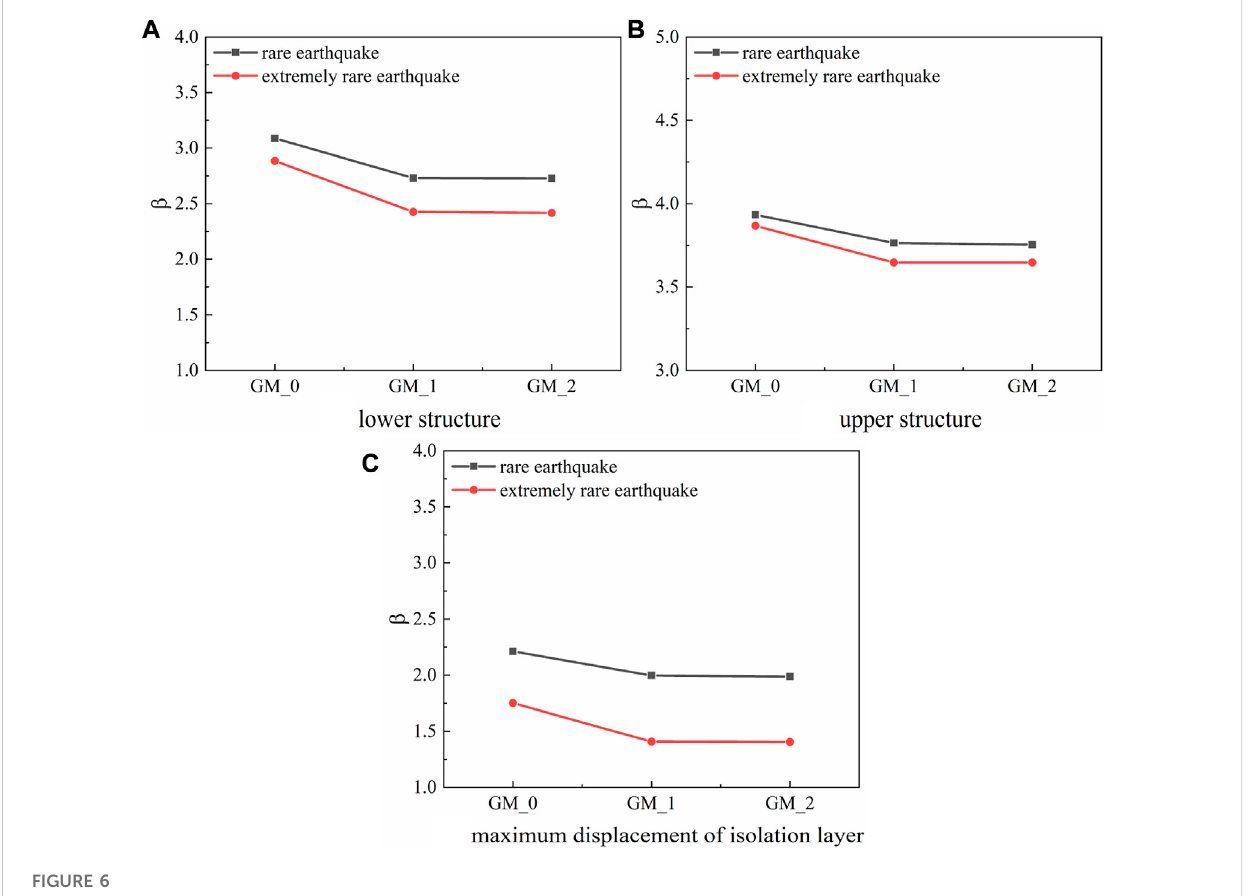
FIGURE 6 Comparison of failure probability of each substructure.